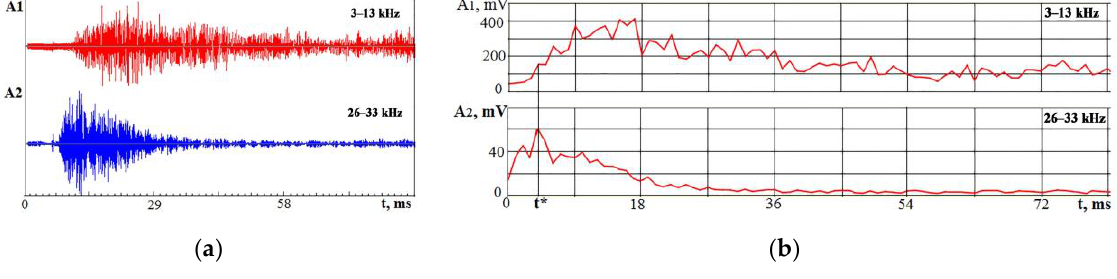
Figure 8. VA signal amplitude changes in time in two frequency ranges under electron beam action on a steel plate at a charging voltage of 22 kV: ( a ) VA signal recordings; ( b ) RMS amplitude of VA signals changes in time. t*—the moment, when the amplitude A 2 reached a maximum.